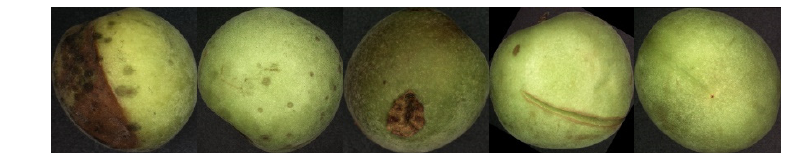
Figure 2. The original image collected by the system.